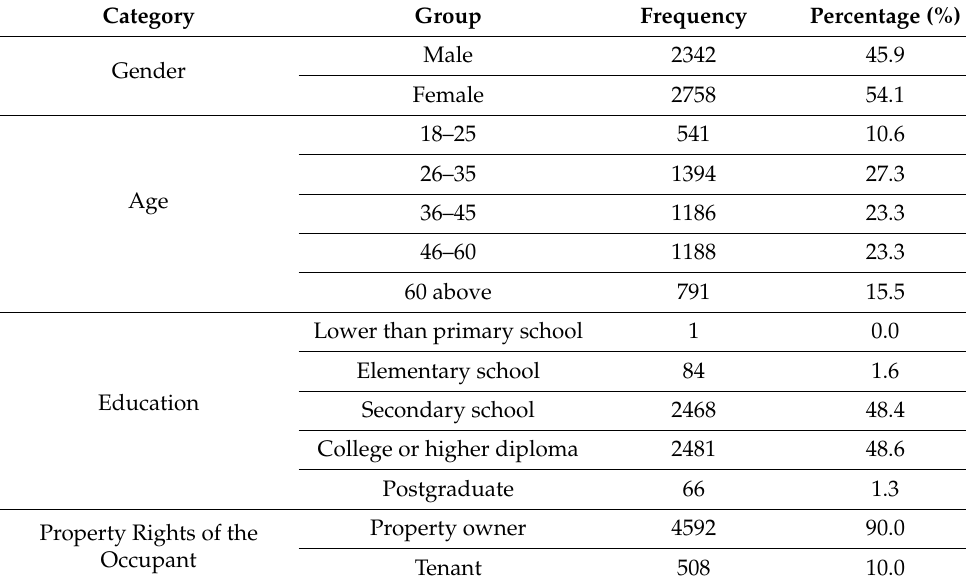
Table 2. Socioeconomic characteristics of all the valid respondents